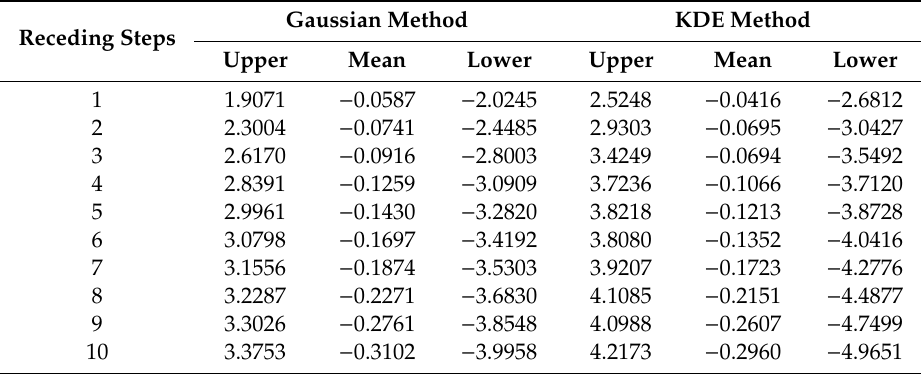
Table 7. Error statistic of receding ten-step wind speed prediction.